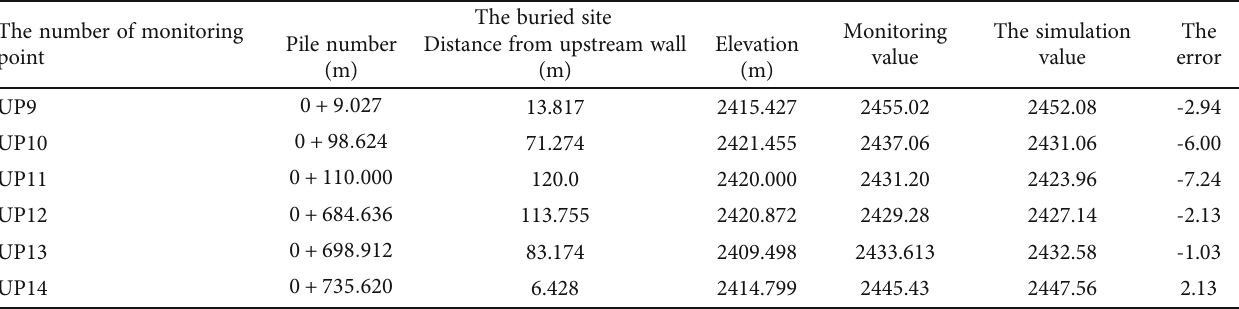
Table 5: The comparison of seepage pressure about dam-around